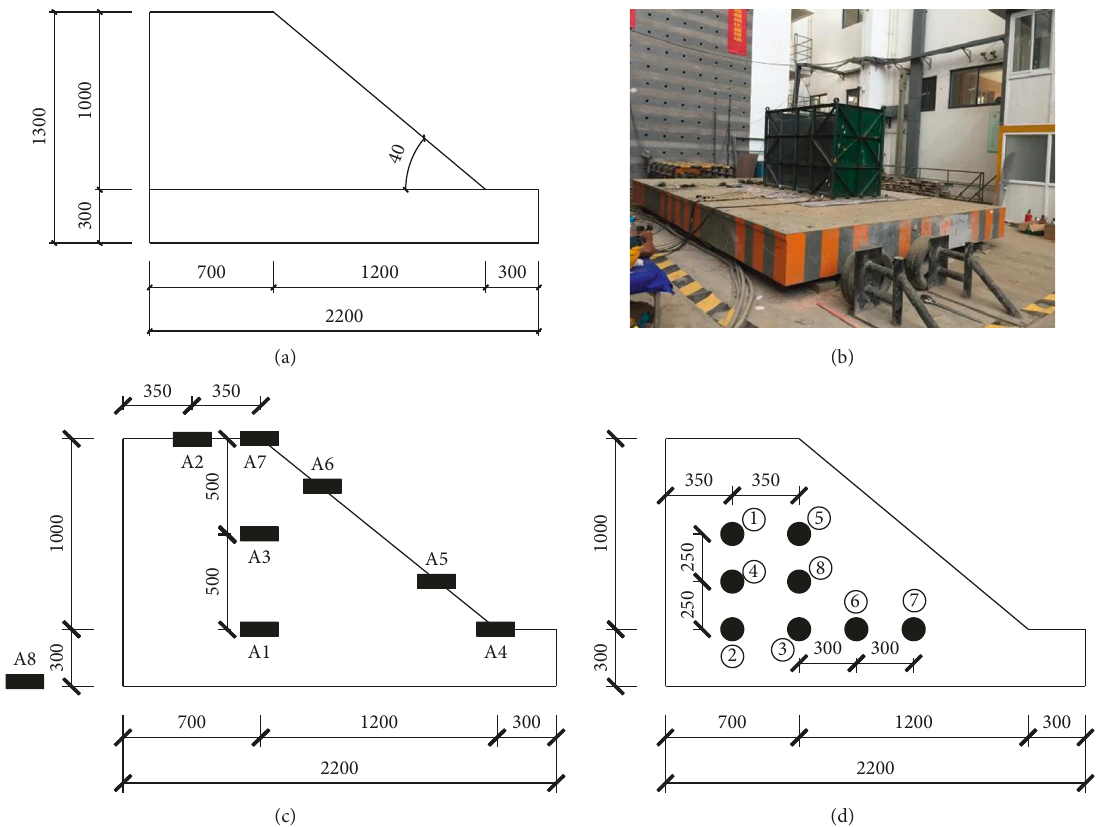
Figure 2: Model details (unit in mm). (a) Model sizes. (b) Model on shaking table in reality. (c) Acceleration sensor configuration. (d) Earth pressure sensor